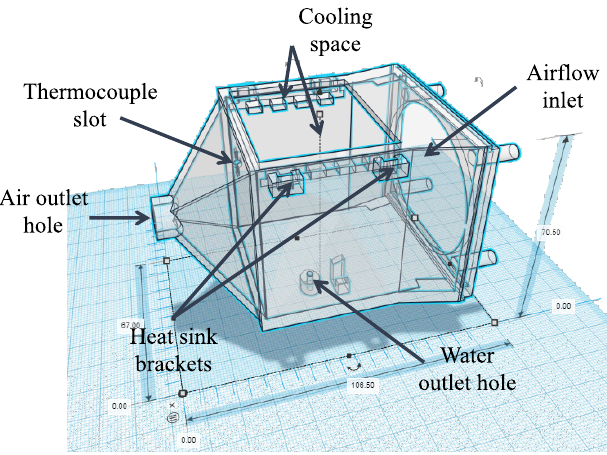
Figure 5. Physical assembly of the cooling